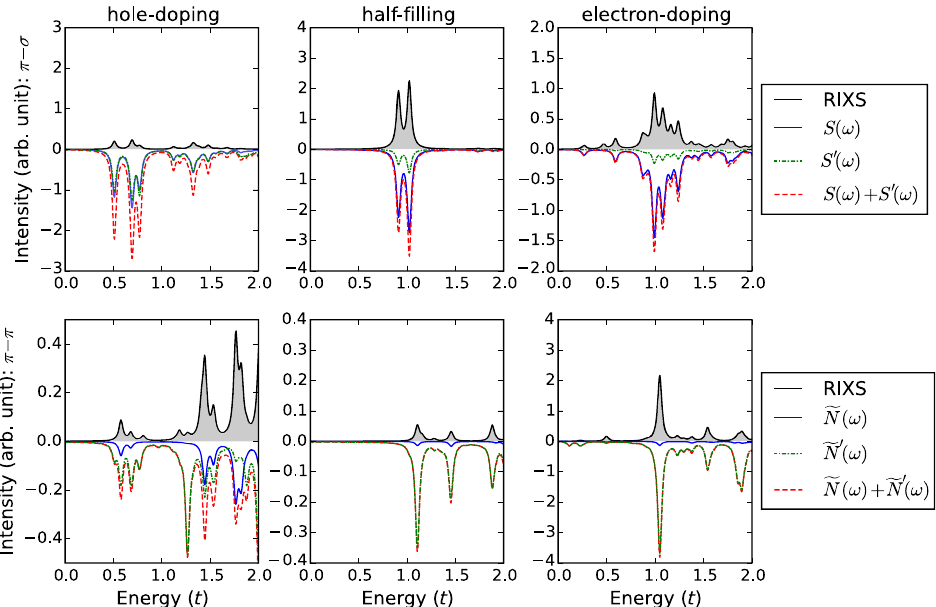
FIG. 2. Exact RIXS cross sections and approximations calculated using exact diagonalization. Top (bottom) panels show spectra for the π − σ ( π − π ) polarization geometries. Left, middle, and right panels show RIXS spectra calculated for n ¼ 0 . 83 ( “ hole-doping ” ), n ¼ 1 ( “ half-filling ” ), and n ¼ 1 . 17 ( “ electron-doping ” ) electron fillings, respectively. The spectra are summed over all momenta along 0 direction, which are accessible in RIXS on a 12-site cluster, weighted with the RIXS form the nodal direction and along the k y ¼ P P 2 S ð q ; ω Þ , ~ N ð ω Þ ¼ 2 ~ N ð q ; ω Þ and similarly for S 0 ð ω Þ and ~ N 0 ð ω Þ . The elastic response has been factors, i.e., S ð ω Þ ¼ q j W π − σ j q j W π − π j removed in each